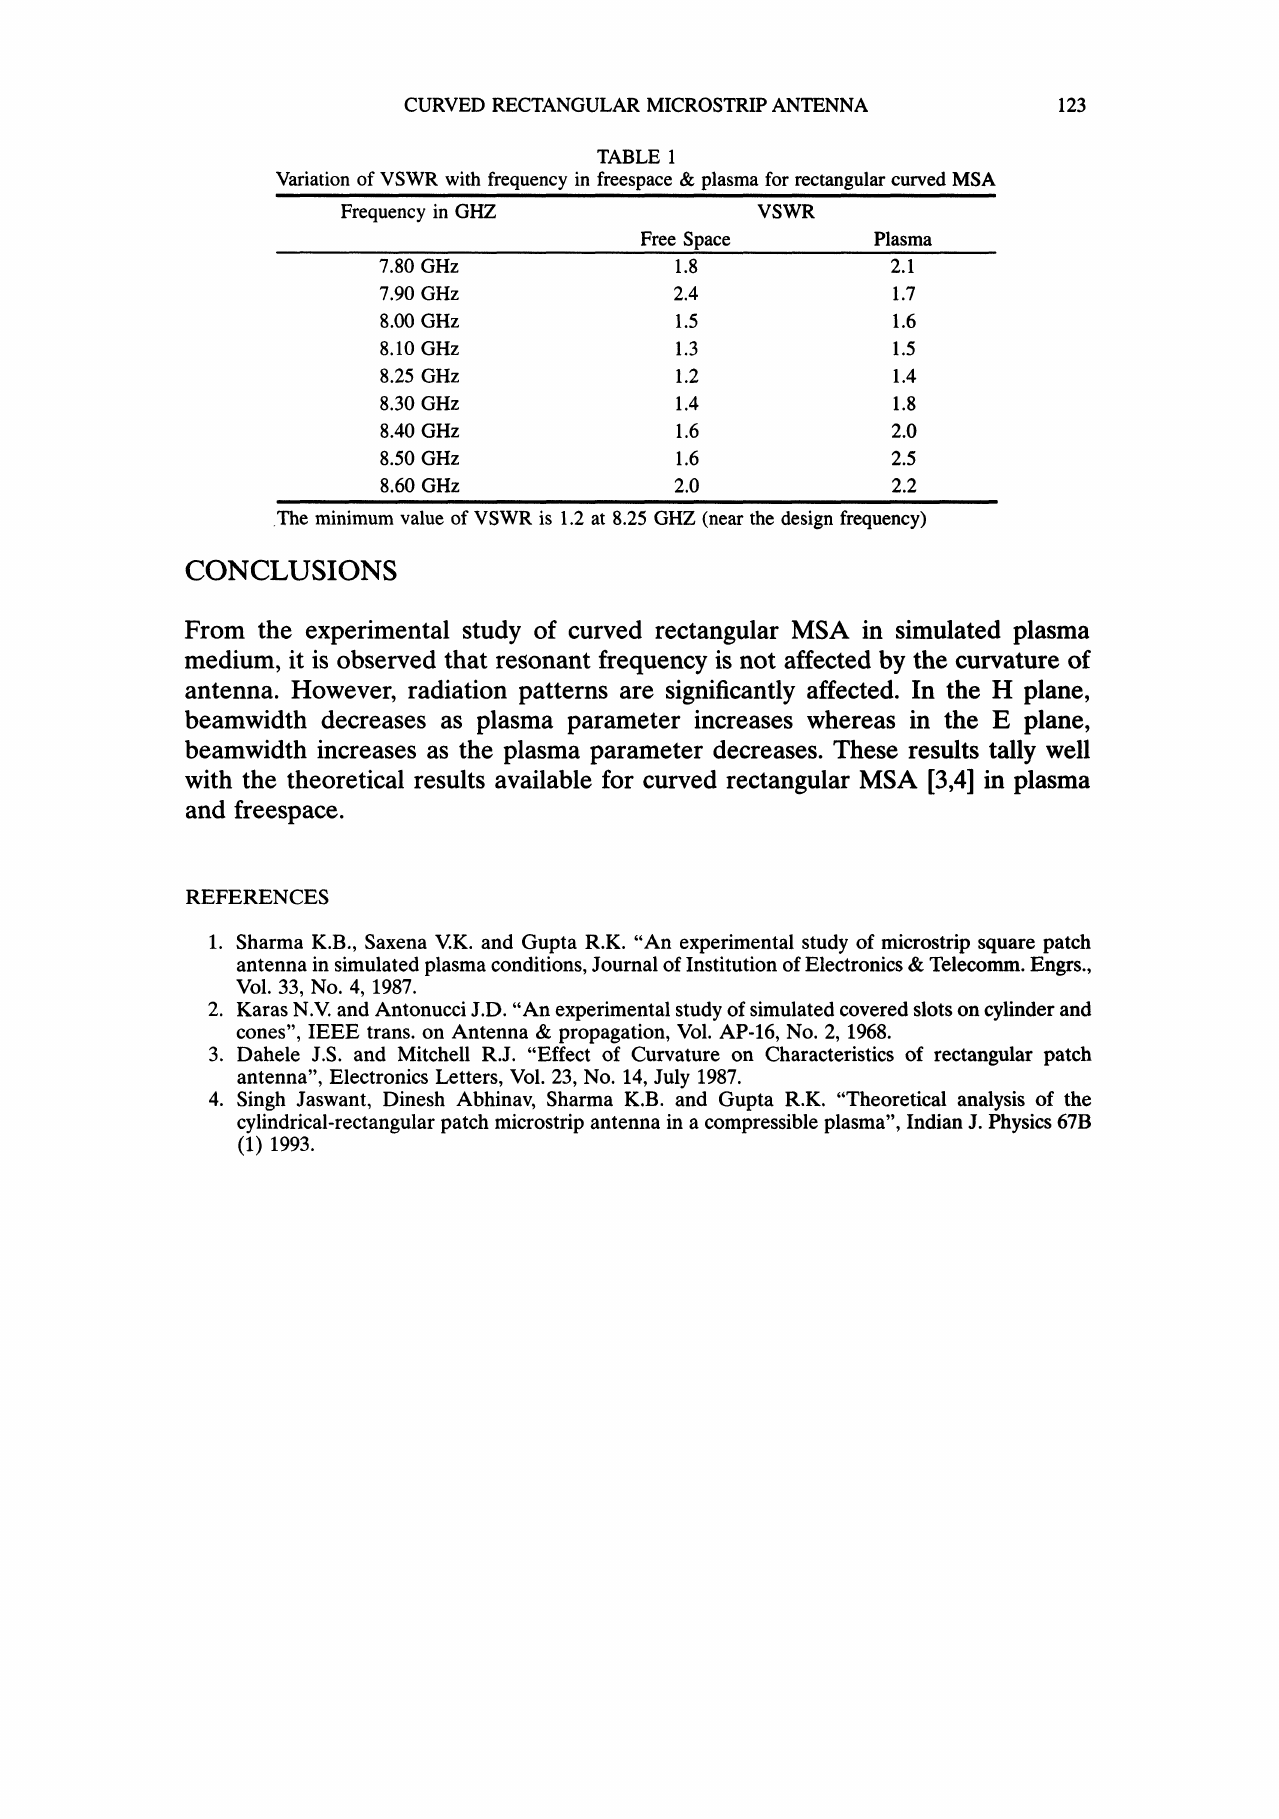
TABLE Variation of VSWR with frequency in freespace & plasma for rectangular curved